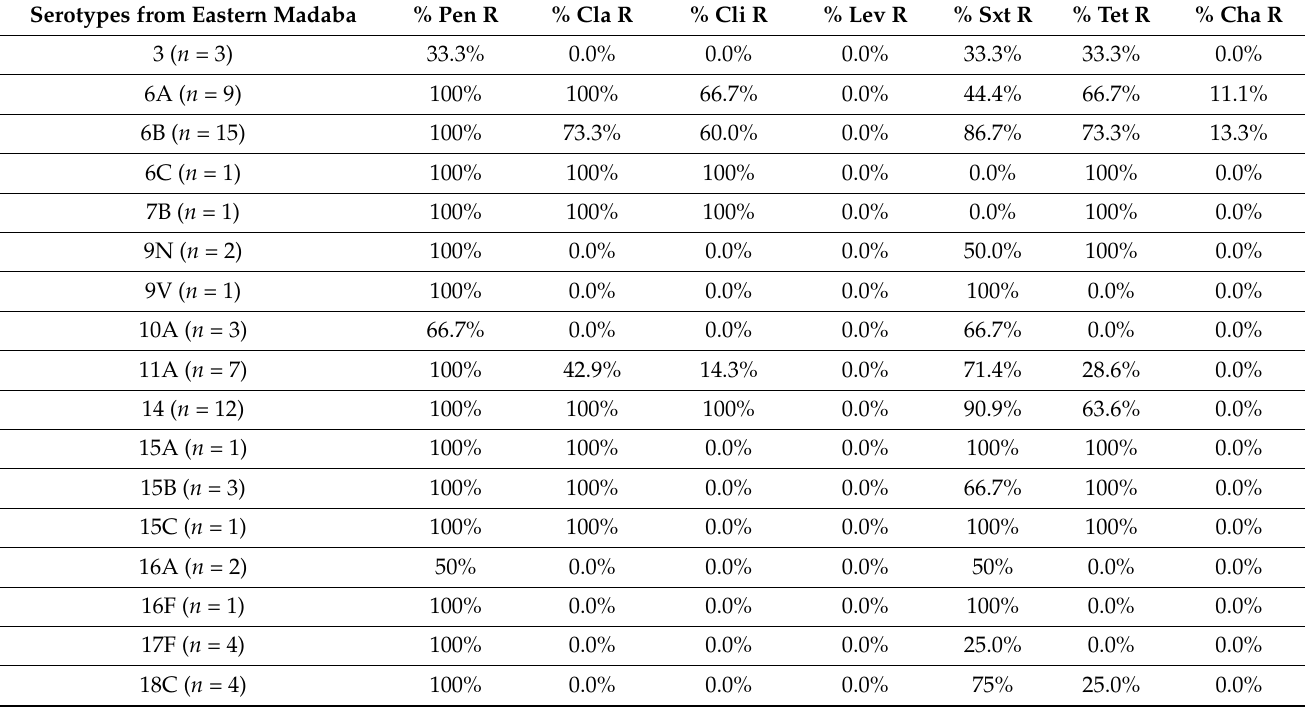
Table 6. Vaccine and non-vaccine serotype-related antibiotic resistance to isolates from eastern